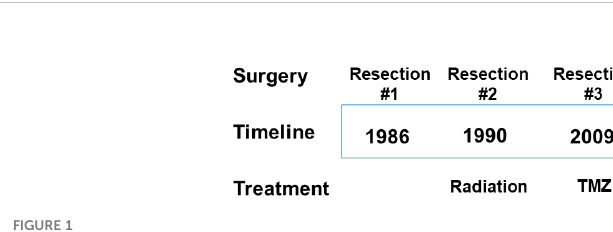
FIGURE 1 Timeline of the disease history and management. TMZ,